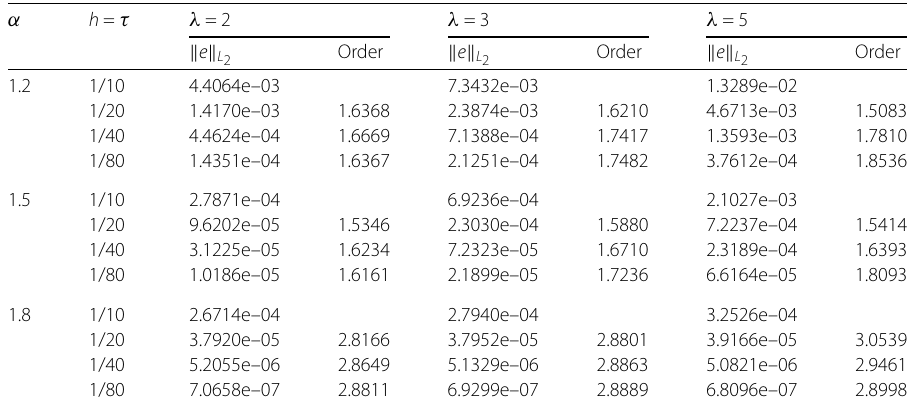
Table 11 Errors and corresponding observation orders at t = 1, γ 3 =